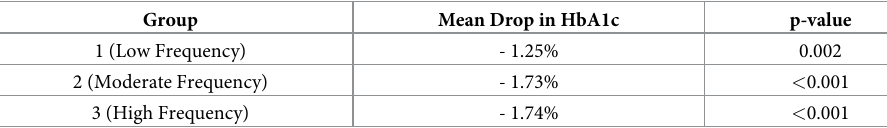
Table 2. Clinical outcome (3-month mean drop in HbA1c) by incentive group.